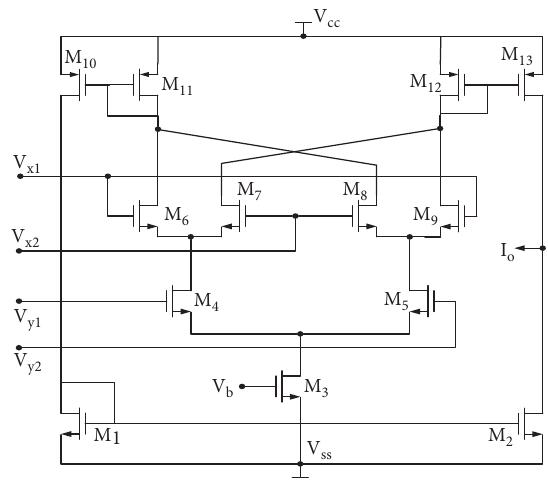
Figure 4: Voltage gain and frequency characteristics of the